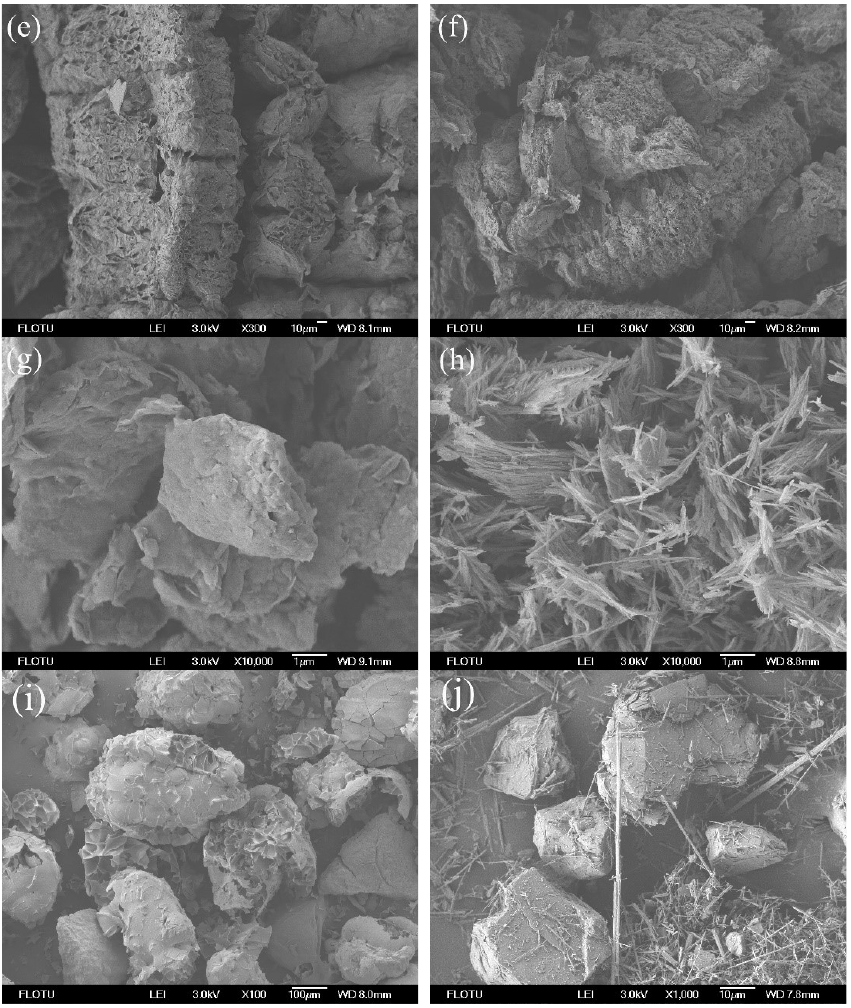
Figure 2. Field Emission Scanning Electron Microscopy (FESEM) micrographs of inorganic porous skeletons: ( a ) Expandable graphite, ( b ) EG400, ( c ) EG500, ( d ) EG600, ( e ) EG700, ( f ) EG900, ( g ) organic montmorillonite (OMMT), ( h ) attapulgite, ( i ) EP, and ( j )